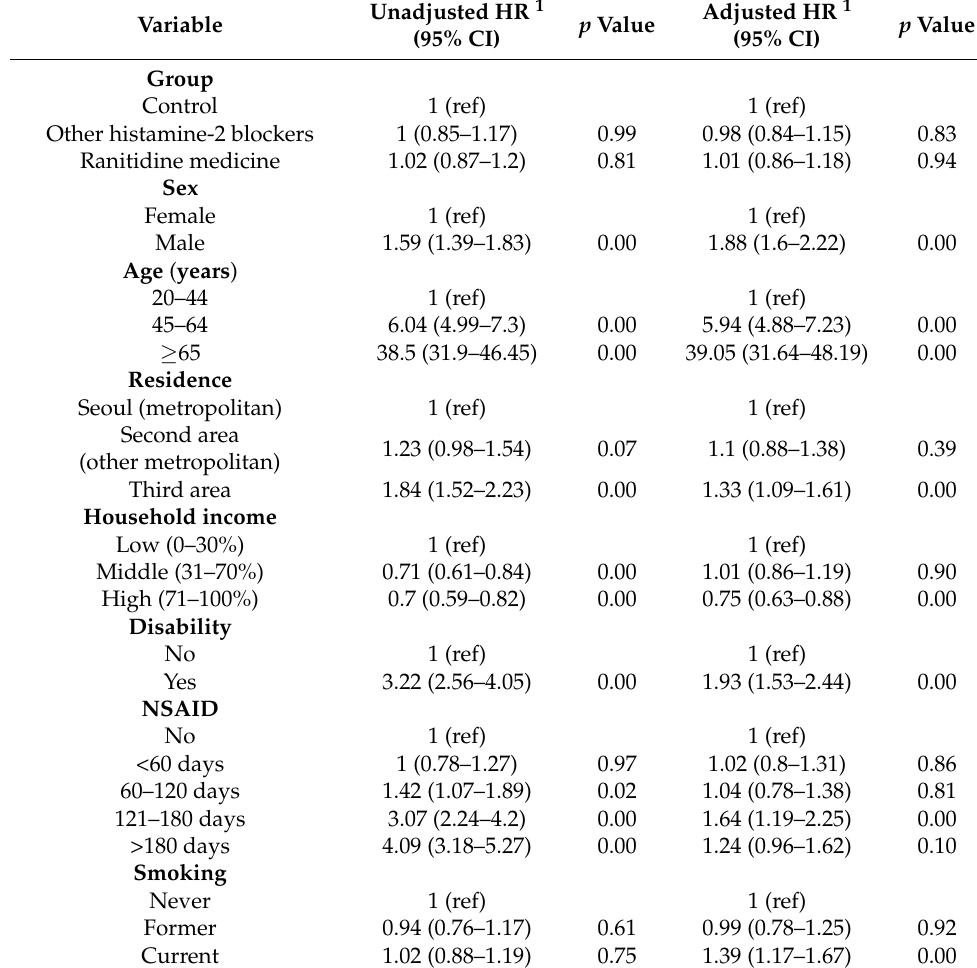
Table 3. Hazard ratio (95% confidence interval) of gastric cancer according to different